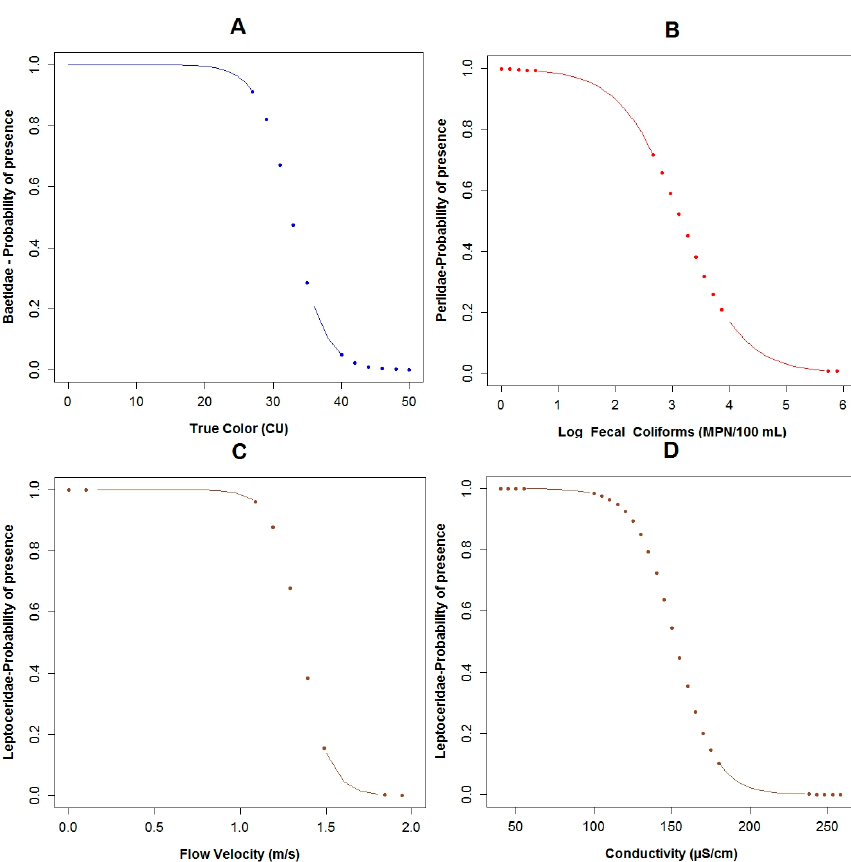
Figure 5. The probability of chosen taxa being present in relation to an explanatory variable: ( A ) Baetidae with color; ( B ) Perlidae with log fecal coliforms; ( C ) Leptoceridae with flow velocity; ( D ) Leptoceridae with conductivity. (The points in the curves indicate extrapolation outside the observed physicochemical variables range).